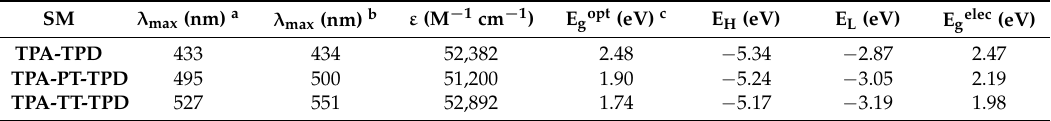
Table 1. Optical and Electrochemical properties of TPA-TPD , TPA-PT-TPD and TPA-TT-TPD .